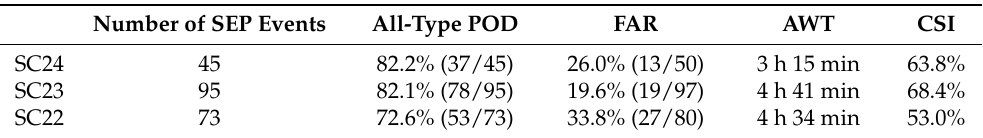
Table 2. Forecasting performance of UMASEP-10 version 1.7 for predicting all >10 MeV SEP events in Bain et al. [2] for the solar cycles 23 and 24, and the events in https://umbra.nascom.nasa.gov/SEP (accessed on 1 December 2021) for the solar cycle 22. Number of SEP Events All-Type POD